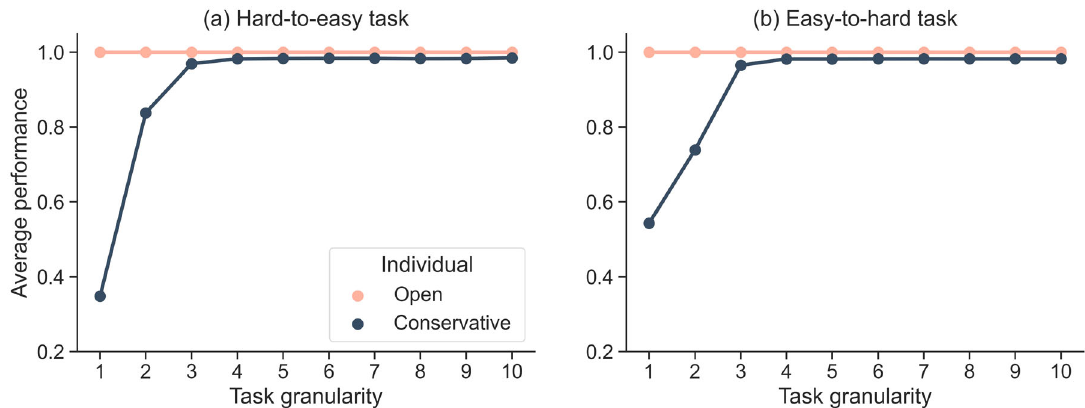
Fig. 4 Performance of open and conservative individuals in two tasks. Average performance of open and conservative individuals in a hard-to-easy task and b easy-to-hard tasks under different granularity. All individuals use the best strategy with sample size m = 3. Based on a fully connected network with N = 100 individuals.